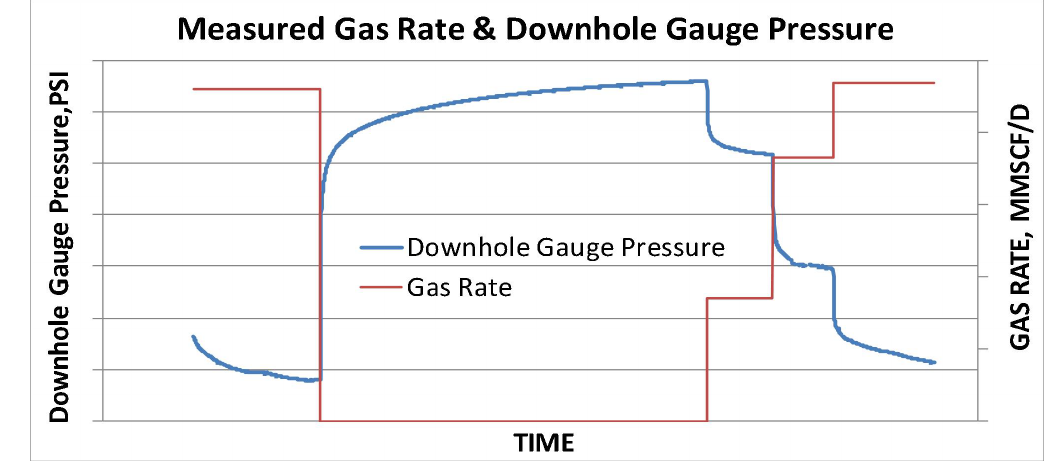
Figure 7—Conceptual well-test design.